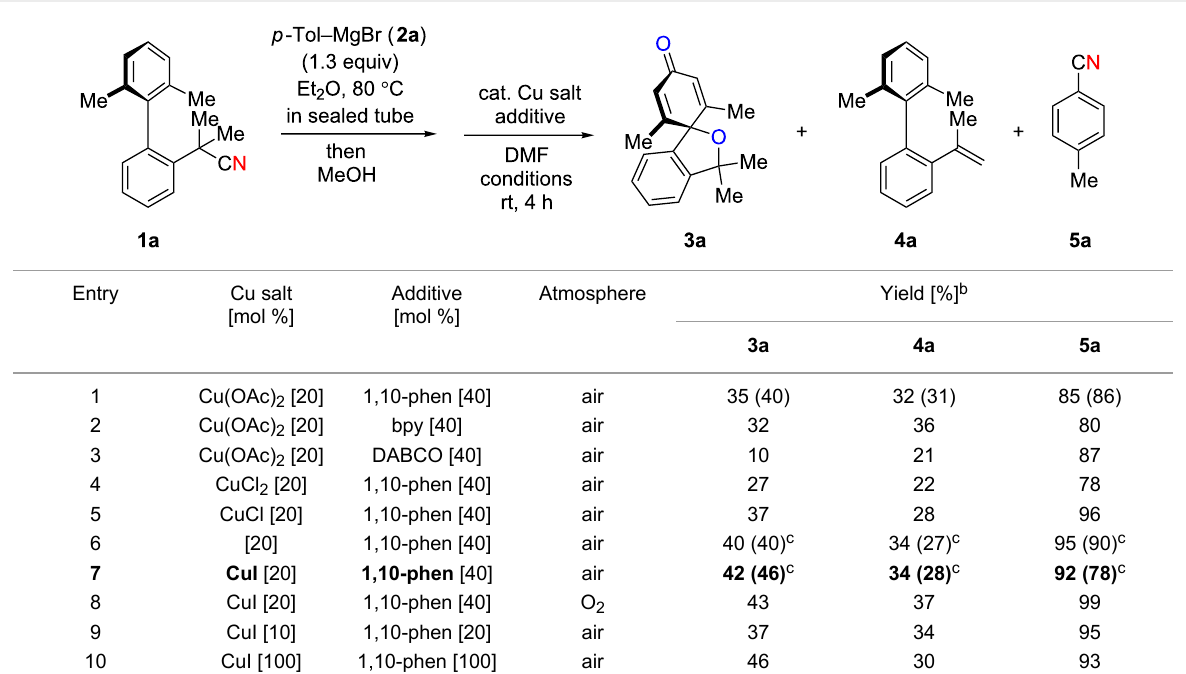
Table 1: Optimization of reaction conditions: oxaspirocyclohexadienone synthesis.